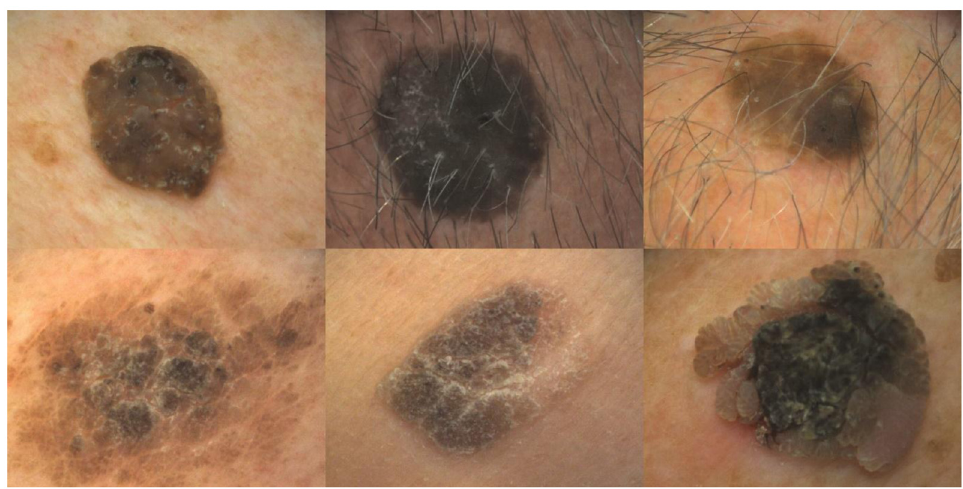
Figure 1. Hyperkeratotic seborrheic keratoses with horn cysts and pseudo-horn cysts (upper row) and without (lower row). This figure is an original image created by the author for this publication and written informed consent was obtained from the patient.